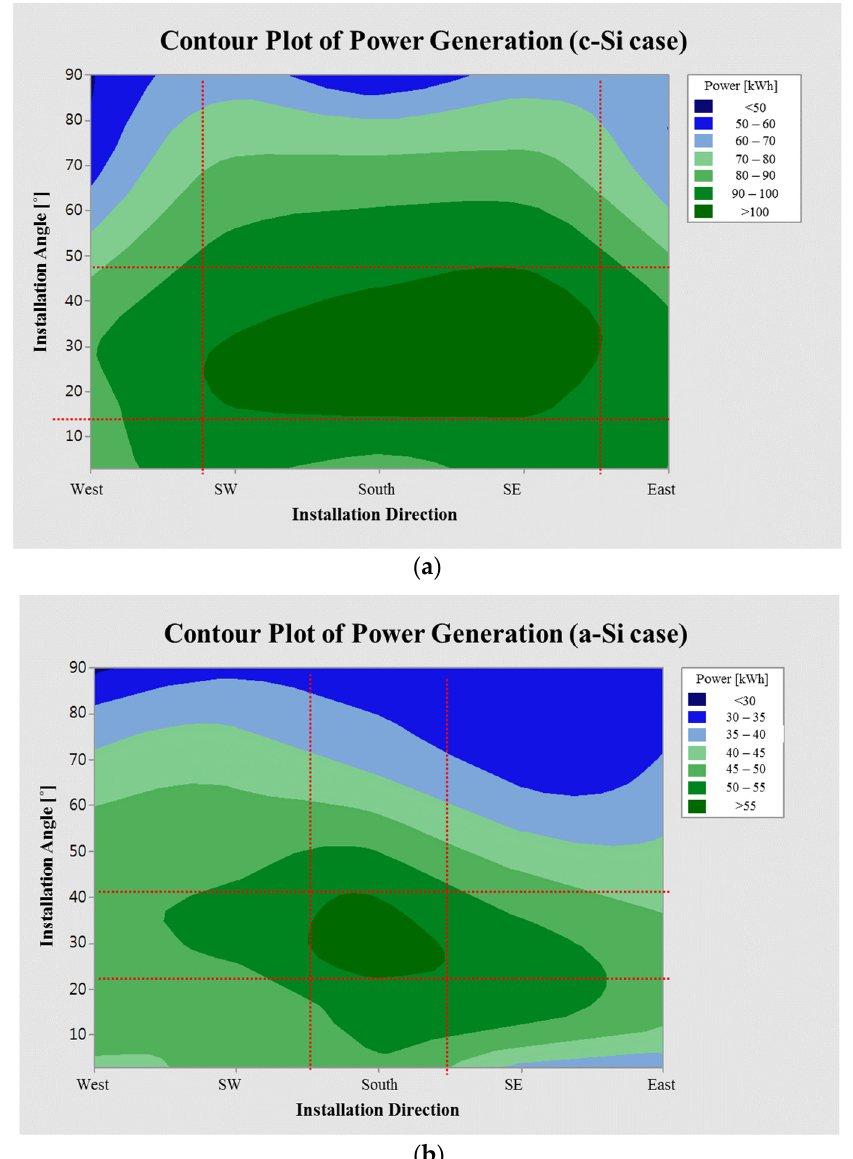
Figure 15. Contour plots of the cumulative power generation over the one year for different installation directions and angles: ( a ) c-Si; ( b ) a-Si.